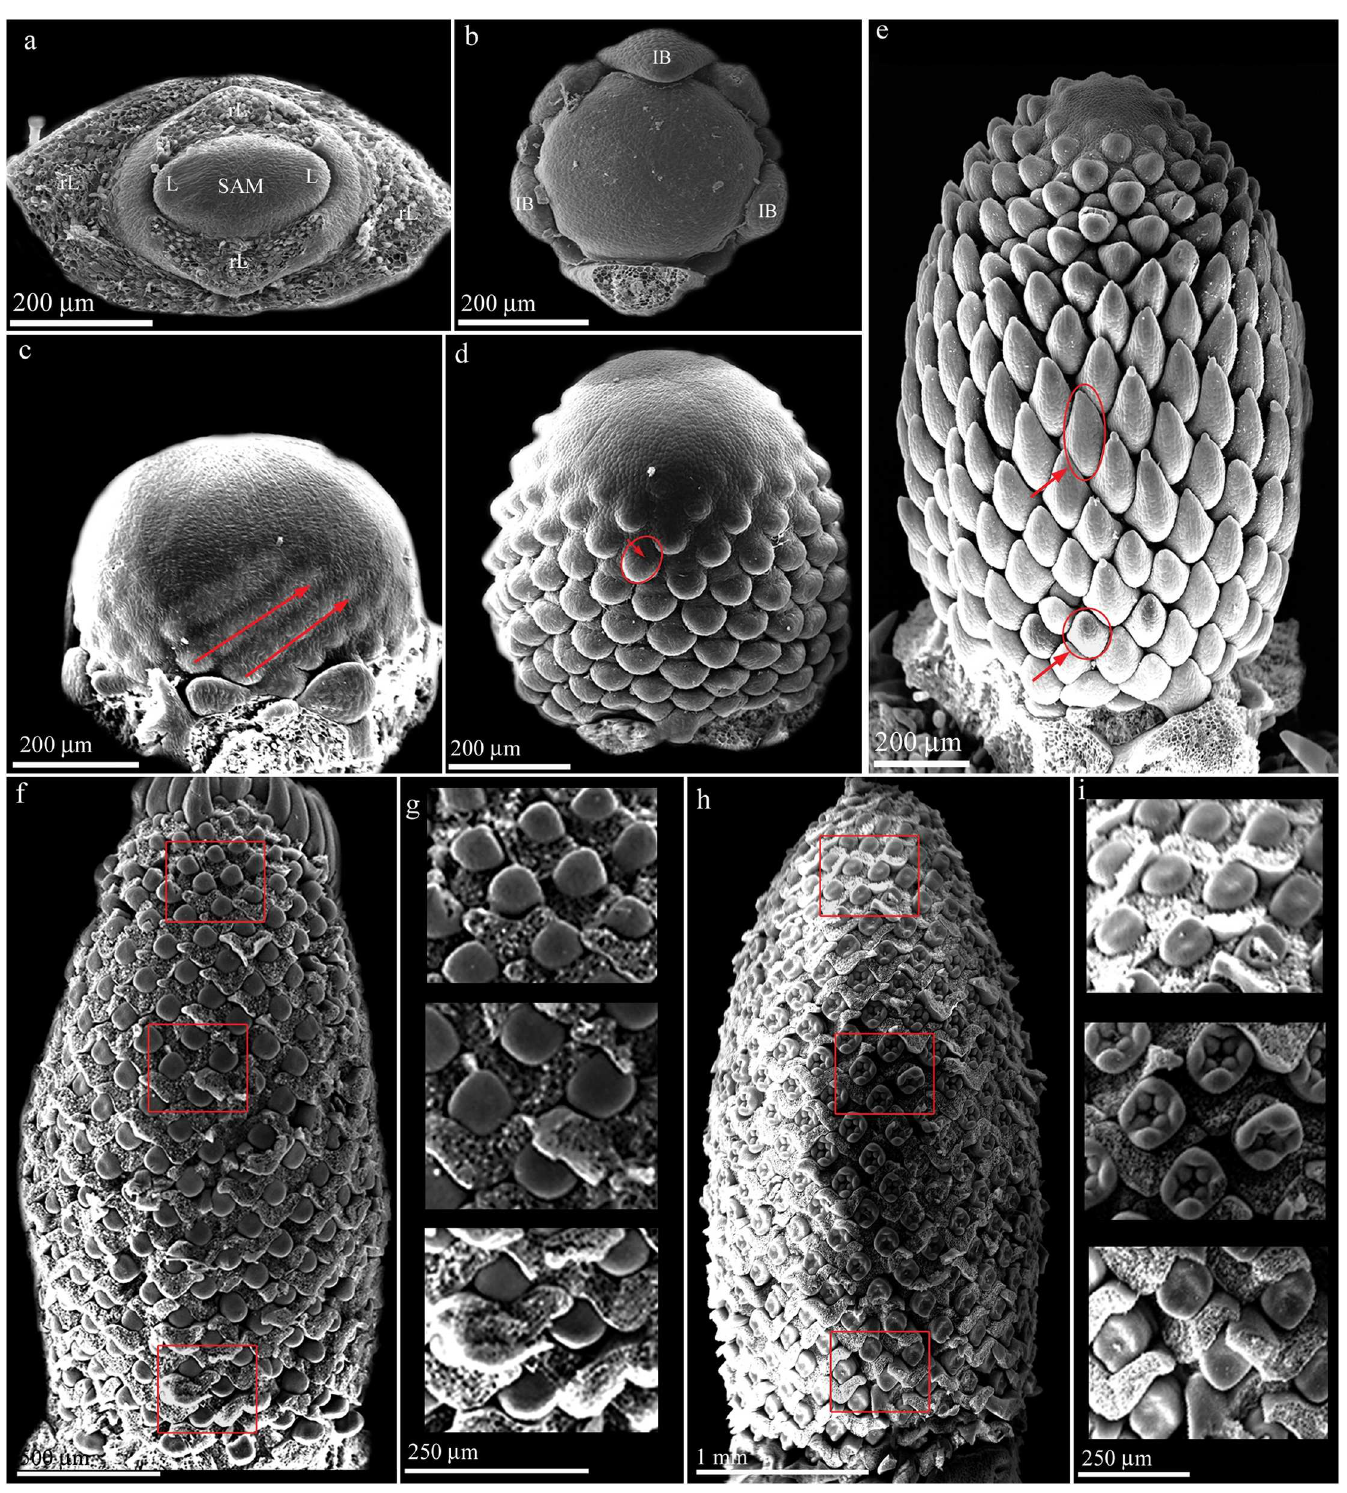
Fig 2. Head development in Dipsacus fullonum . (a) Vegetative shoot apicalmeristem (SAM). (b) Naked head meristem. (c) First flowers are initiatedin contact parastichies; some parastichies are delayedcomparedto adjacentones (arrows). (d) Elongationand expansionof the head meristem and acropetal formation of parastichies. (e) Completionof floral initiation.Note the spindle-likeshape of the meristem and the smaller size of the basal bracts (arrow) comparedto the middleones (arrow). (f) Mature head with all bracts removedexcept at the top. (g) Details from (f) showingthe larger size of the middle